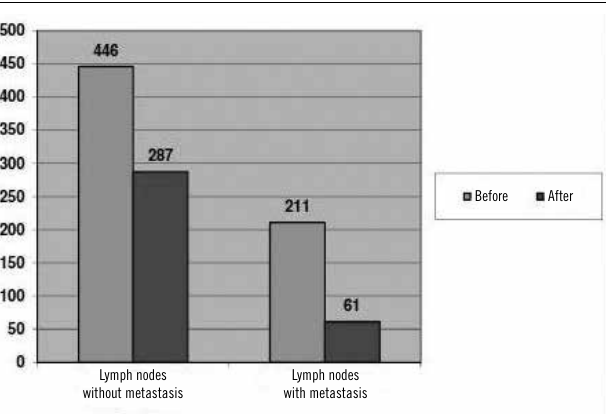
figurE 2 − Number of metastatic and non-metastatic lymph nodes before and after LRS LRS: lymph node revealing solution.